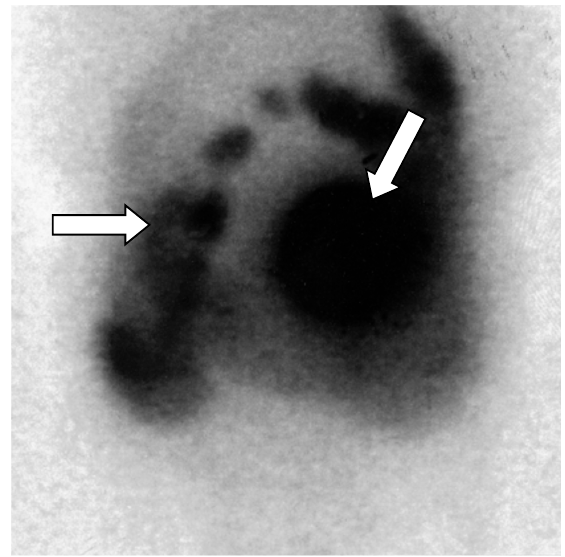
Figure 5. Octreoscan scintigraphy (Octreotide labelled 111-Indium _ 111 In-DTPA-octreotide) showing tumor-free uptake of the pancreatic head (arrows). There is normal absorption of the marker by the liver, spleen, and kidney. Normal excretion of non-intestinal radioactivity is observed [18]. Scintigraphic exams with somatostatin analogues of the pancreas can be performed every three years. These tests are not performed annually because it is known that, mainly in the case of pancreatic tumors, its diagnosis is based almost exclusively on biochemical screening by the detection of Chromogranin-A, since the abnormality of pancreatic hormones precedes the radiological detection of these tumors by at least five years [54]. 7. Prognosis PPoma remains a reserved prognosis neoplasm due to its aggressive biological power, both locally and in relation to the spread of the disease [36]. The poor prognosis of this neoplasm is, in part, related to the difficulty of early detection. When the first symptoms appear, the majority of the patients present at an advanced stage of disease, usually metastatic, where curative surgery is no longer possible [13,76]. In this case, we pay attention to some initial symptoms, such as epigastric malaise, diarrhea or jaundice is crucial and should not be neglected [12,13,17,33,76]. Surgical resection is only performed in approximately 20% of cases, although it is the treatment of choice. Surgeries for tumor volume reduction are also performed to alleviate the effects of mass and malignant behavior. Complementary therapies are generally ineffective. Unfortunately, there is currently no sensitive and effective screening test for the early detection of PPoma or even to identify individuals predisposed to the development of this neoplasia [14,18,36]. 8. Staging Staging must be performed from two anatomical and functional points of view, besides TNM. Anatomic staging should be performed by computed tomography (CT) of the thorax, abdomen and pelvis, and nuclear magnetic resonance imaging (MRI) of the liver may be useful in the characterization of liver metastases (Figures 6–8). Upper digestive endoscopy with ultrasonography (US) helps to detect small lesions, allowing needle biopsy. Octreoscan, restricted to some centers, is an important staging test, and is important for in vivo evaluation of tumor expression of somatostatin type 2 receptors. In-111-labeled octreotide scintigraphy in combination with conventional imaging (CT or MRI), has improved the detection of primary and metastatic lesions, as well as selecting patients for radioactive therapies. However, research aimed at early detection